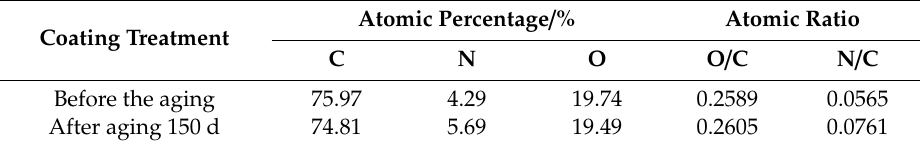
Table 2. Elemental composition and atomic ratios of polyurea before and after aging. Figure 12. XPS full spectrum analysis before and after polyurea aging.